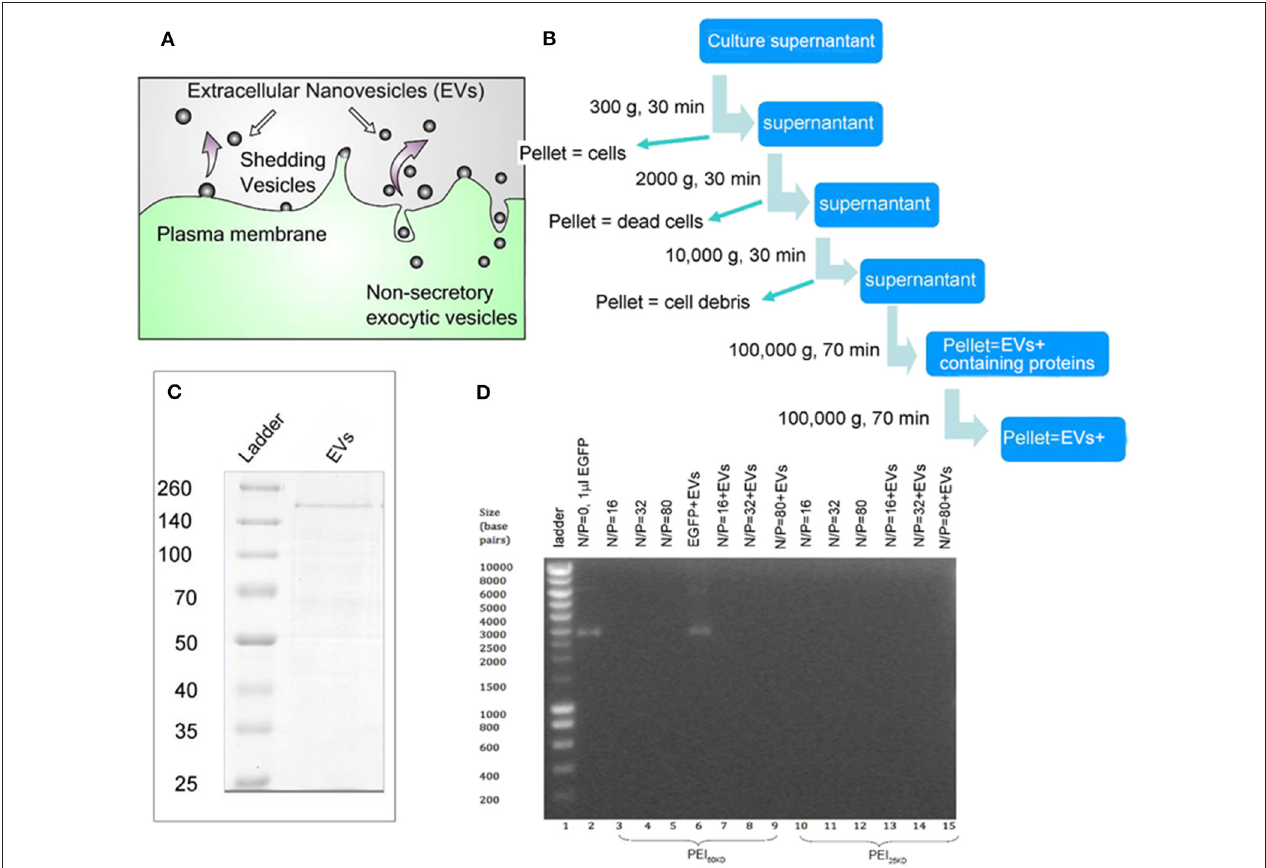
FIGURE 1 | (A) Schematic representation for EV generation from cells. (B) EV isolation process by multiple centrifugation. (C) SDS PAGE gel of EVs, showing a thick band with molecular weight of ∼ 200 kD and a few thin bands between 50–200 kD using Coomassie Blue staining. (D) Band-shift assay of DNA, PEI/DNA complexes, and PEI/DNA/EVs complexes, at different N/P ratios (the molar ratio of nitrogen in PEI to phosphor in DNA). In (D) PEI 60kD was used in lanes 3–9 and PEI 25kD was used in lanes